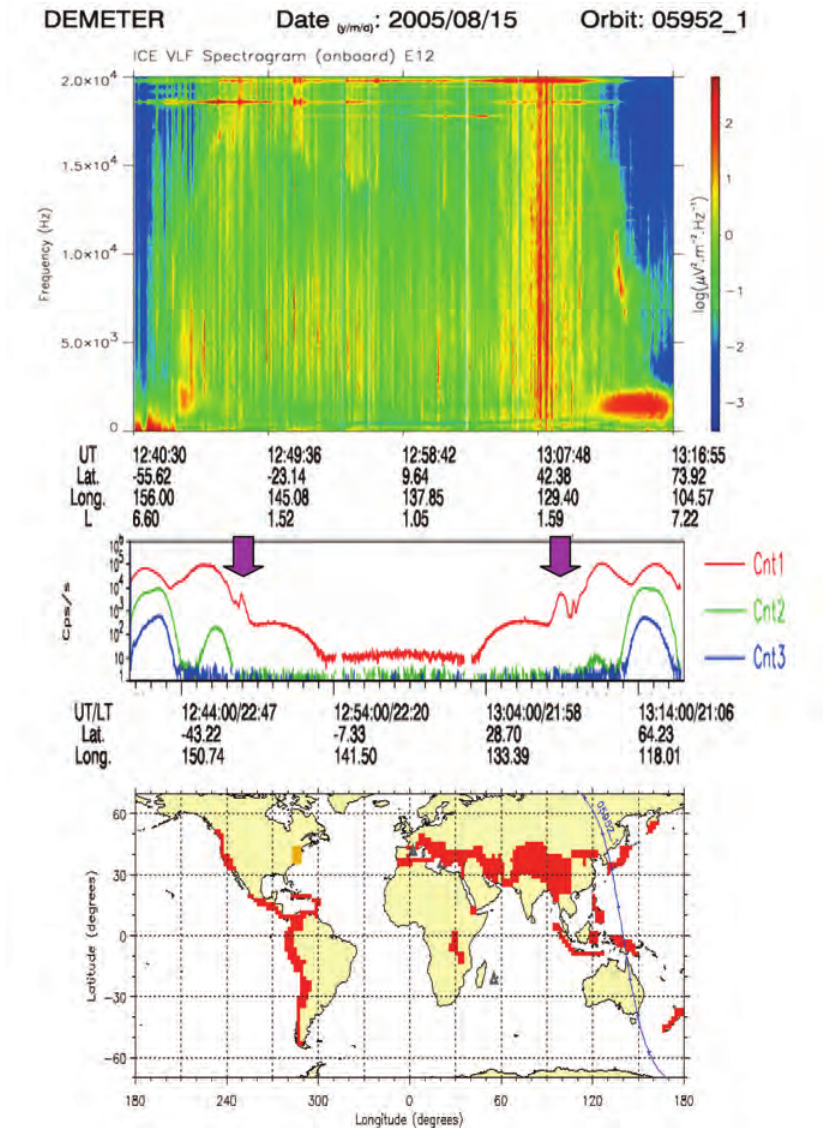
Figure 1. Observations from the DEMETER satellite during an upward semi-orbit, about half a day before the earthquake of August 16, 2005, in eastern Honsu, Japan. (a) Spectrogram of the electric field in the frequency range 0 kHz to 20 kHz. (b) The intensity of the electrons from the IDP experiment in the energy regions of 72 keV to 526 keV, 526 keV to 971 keV, 971 keV to 2350 keV. (c) The DEMETER orbit projected on an Earth map. An electron intensity peak at ~12:48 (~29˚S) UT in (b) is well correlated with a strong broadband VLF signal observed near the earthquake